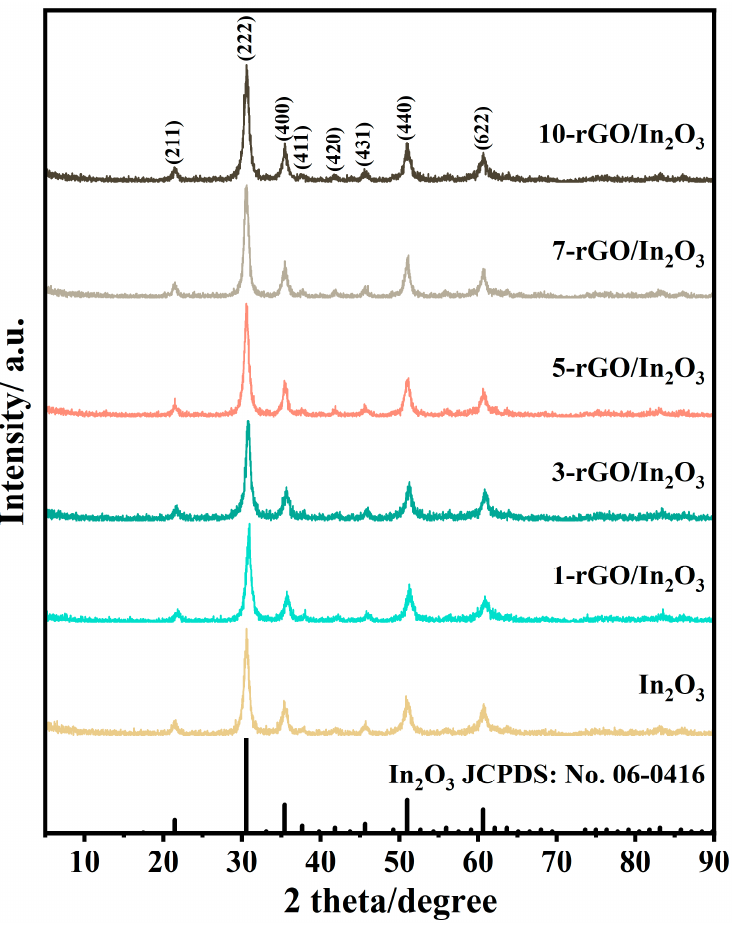
Figure 2. XRD patterns of the pure In 2 O 3 , 1-rGO/In 2 O 3 , 3-rGO/In 2 O 3 , 5-rGO/In 2 O 3 , 7-rGO/In 2 O 3 , and 10-rGO/In 2 O 3 .